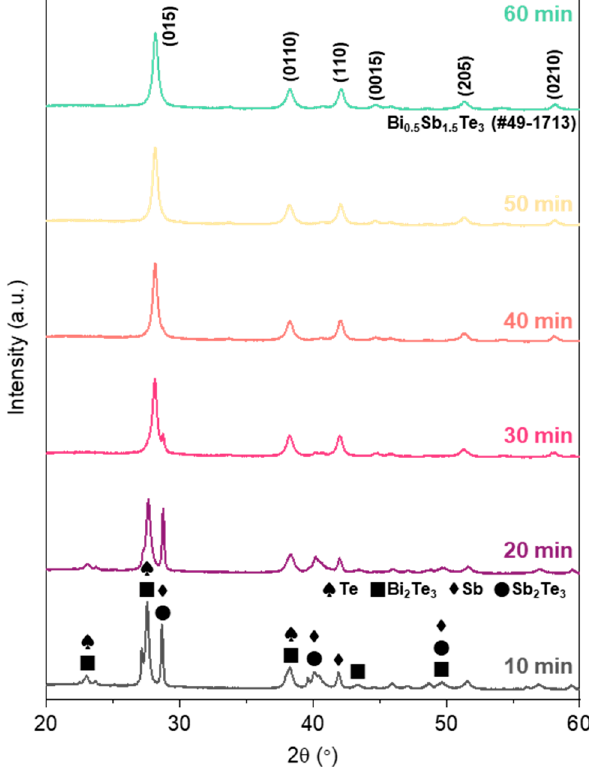
Figure 1. X-ray diffraction (XRD) spectra of Bi 0.5 Sb 1.5 Te 3.0 (BST) nanoparticles (NPs) as a function of mechanochemical process (MCP) time.